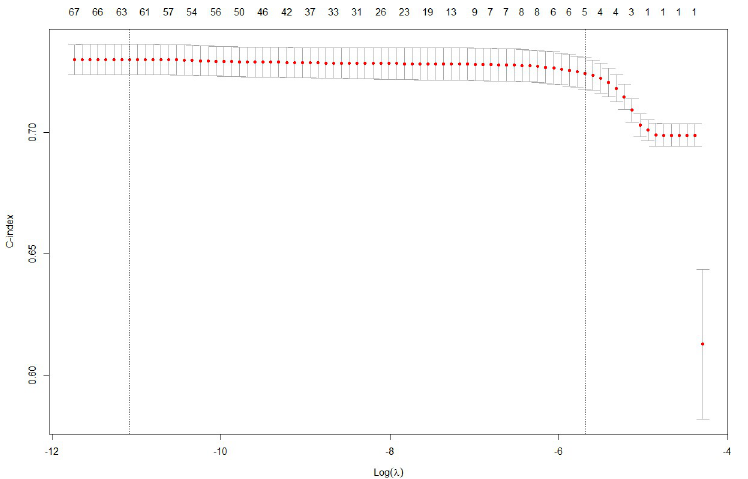
Fig 4. Feature selection for Min Model. Lasso lambda versus Features impact.